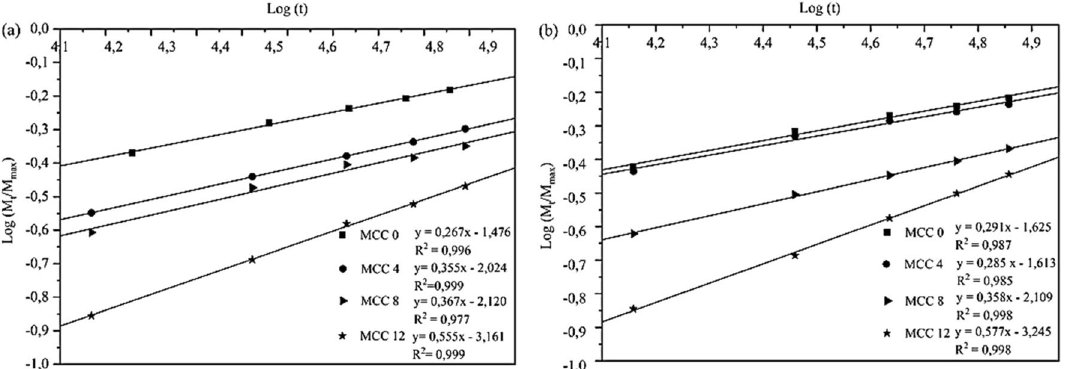
Figure 8. The curve of dimensional changes ( h m ) of composites immersed in ( a ) distilled water (pH 7), ( b ) seawater (pH 8), and ( c ) the acidic solution (pH 3).